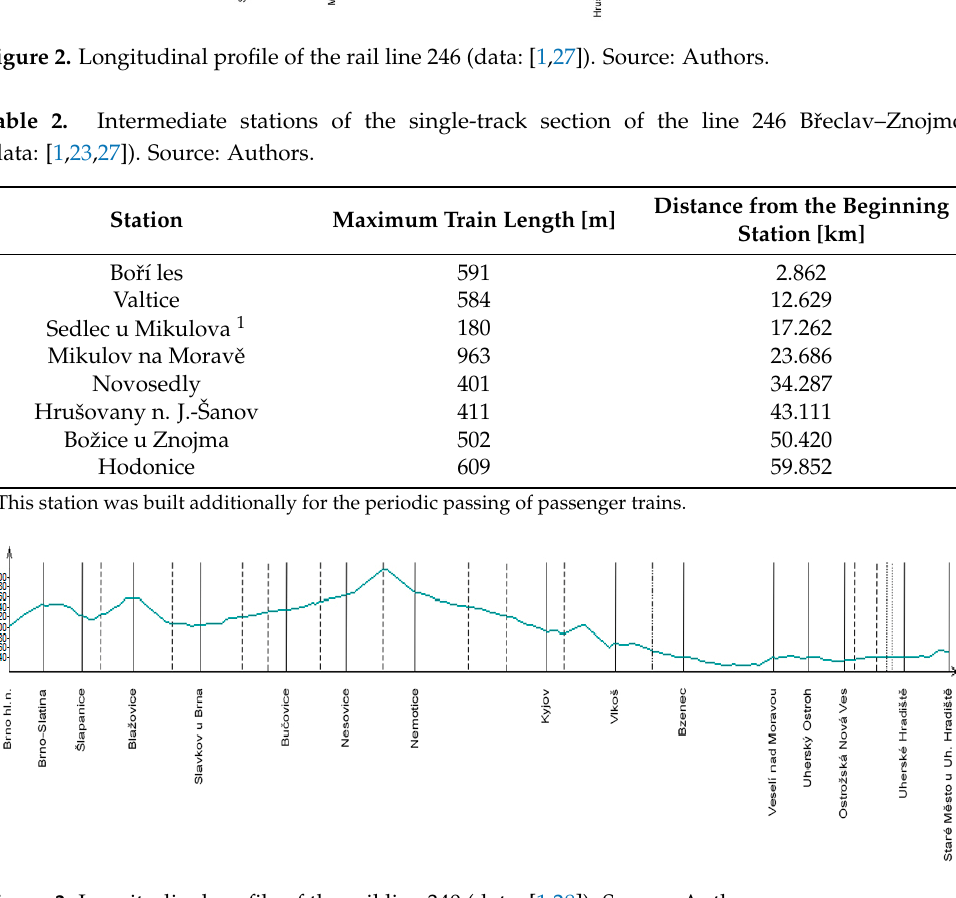
Figure 3. Longitudinal profile of the rail line 340 (data: [1,28]). Source: Authors. Table 3. Intermediate stations of the single-track section of the line 340 Staré M ě sto u U. H.–Brno